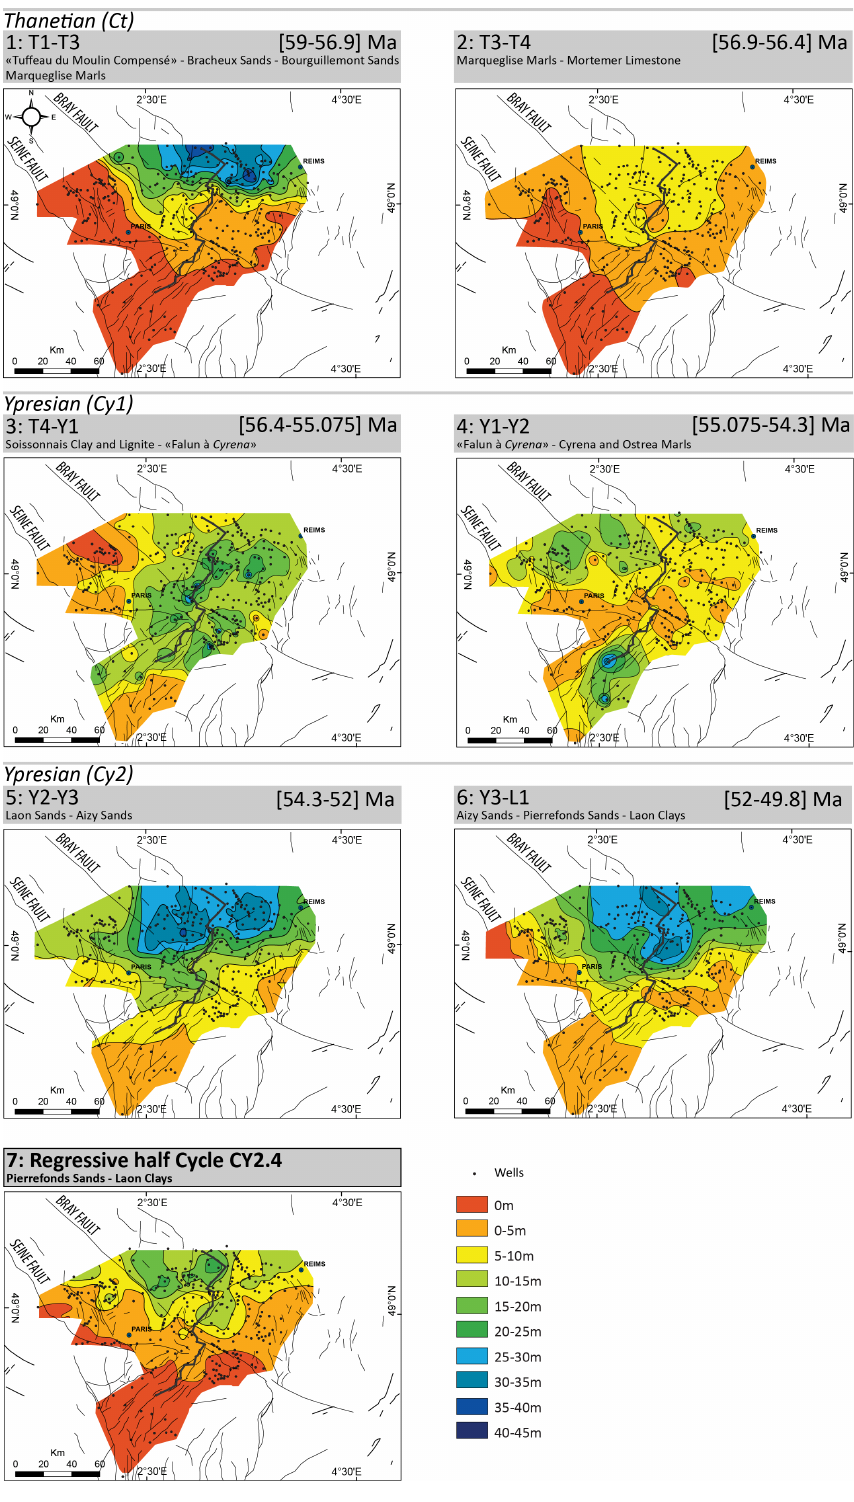
Figure 8. Isopach (sediment thickness) maps for each transgressive or regressive hemicycle of the three third-order cycles: Thanetian (Ct), Ypresian 1 (Cy1), Ypresian 2 (Cy2), and for the last fourth-order cycle of the regressive trend of Cy2, illustrating the erosion during the late Ypresian